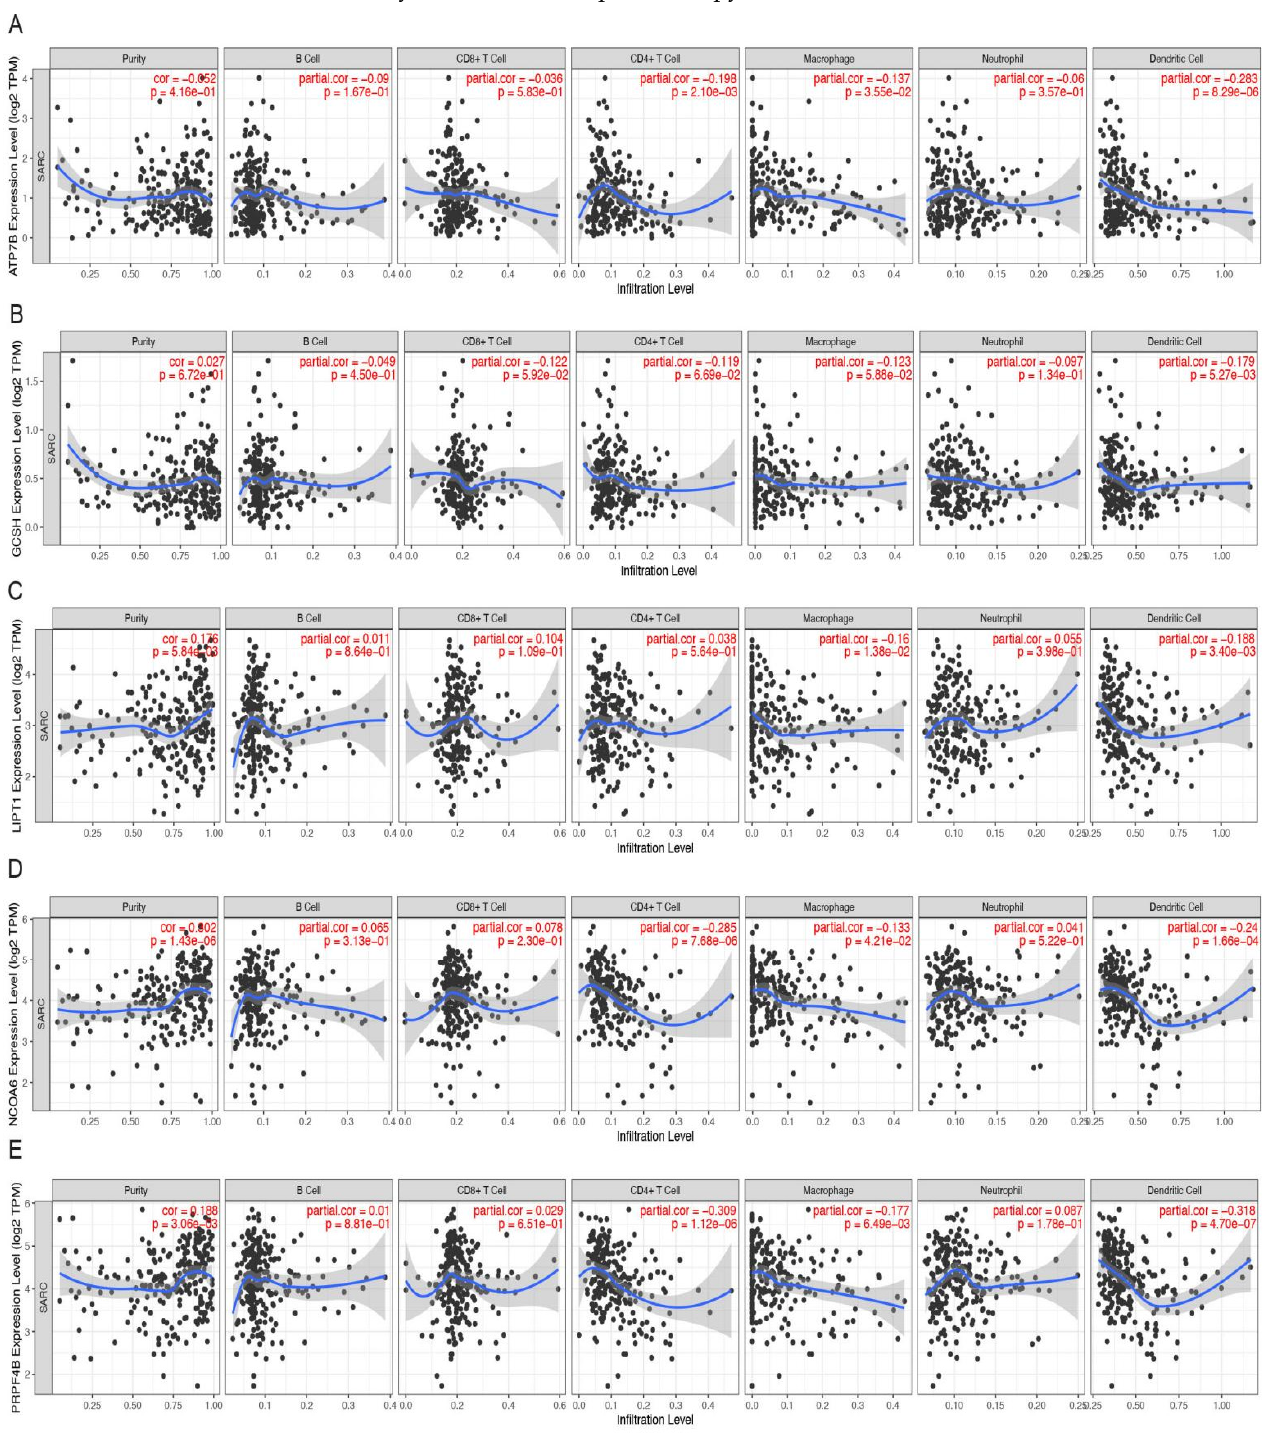
Figure 7. Relationships between expression of five hub genes and tumor immune infiltrations. ( A ) LIPT1, ( B ) GCSH, ( C ) ATP7B, ( D ) NCOA6, ( E ) PRPF4B.